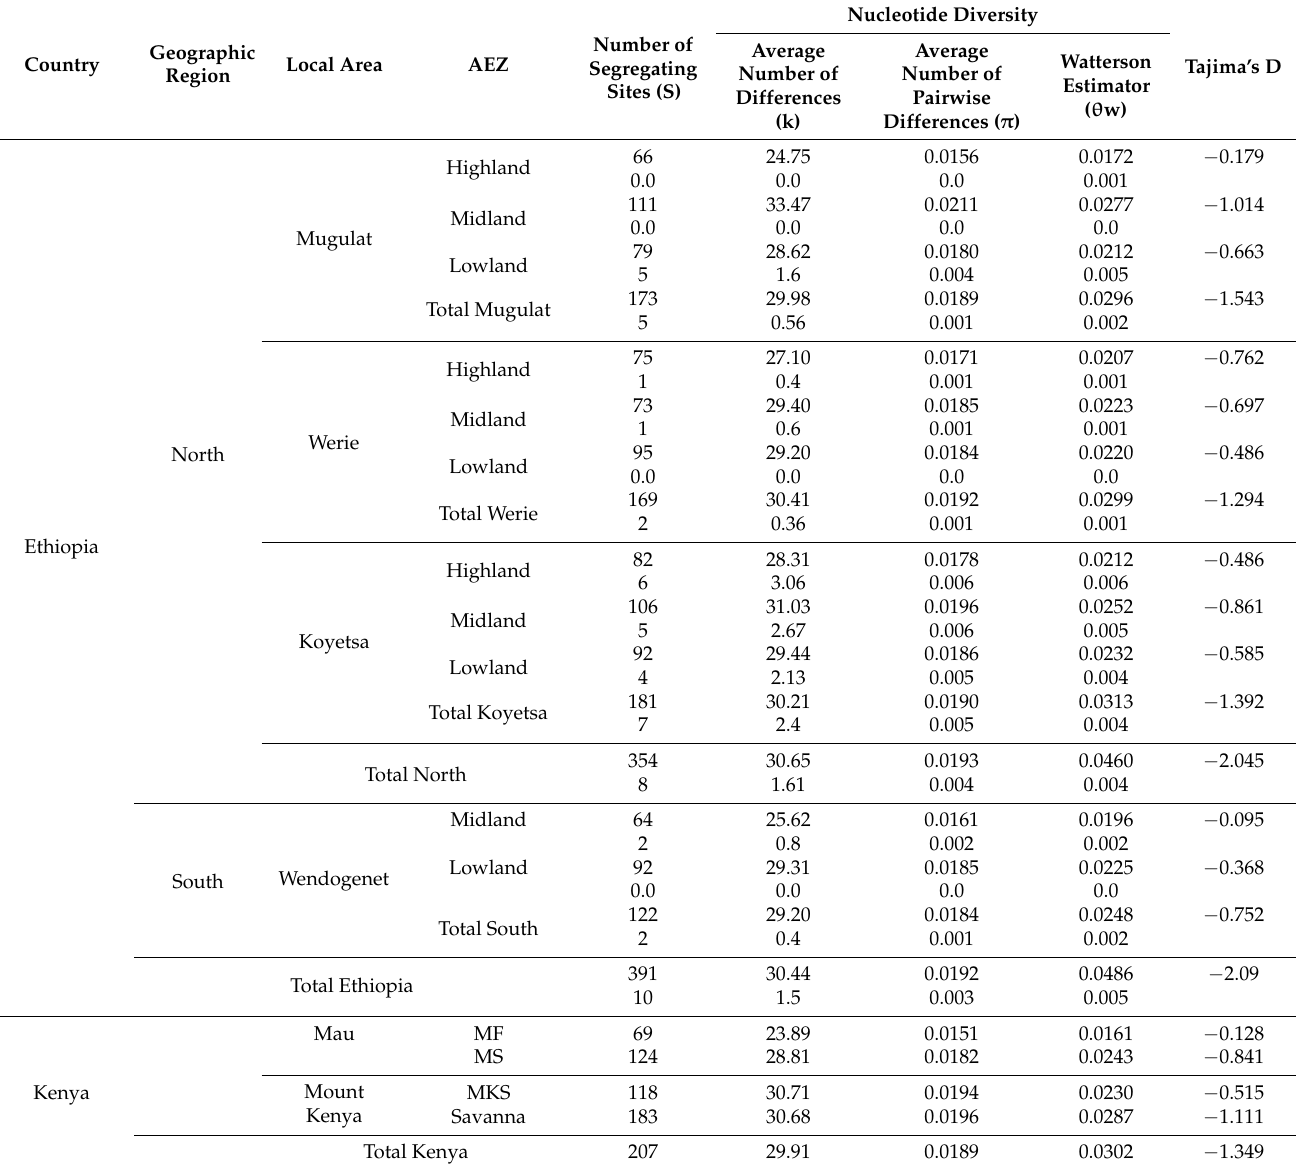
Table 2. Population genetic parameters for the highland, midland and lowland agro-ecological zones (AEZs) of four local areas of Ethiopia and Kenyan reference samples from mountain forest and savannah areas of Mau region and Mount Kenya. For Ethiopian samples, data are given for r7- frag (first rows in each group) and COI-COII (second rows in each group) and for Kenyan samples,